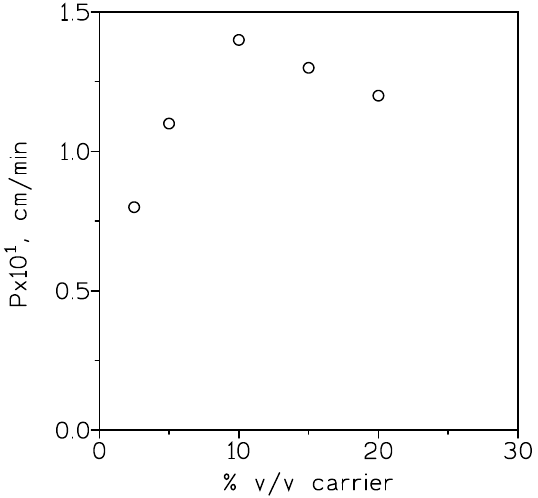
Figure 3. Indium(III) permeability versus carrier concentration. Feed phase: 0.01 g/L In(III) and 7 M HCl. Stirring speed: 865 min −1 . Membrane phase: carrier solutions in Solvesso 100 immobilized in the